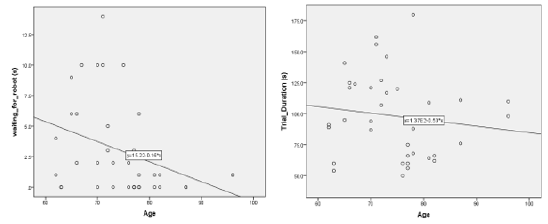
Figure 8: left) Correlation between age and waiting time; right) Correlation between age and time spent with the